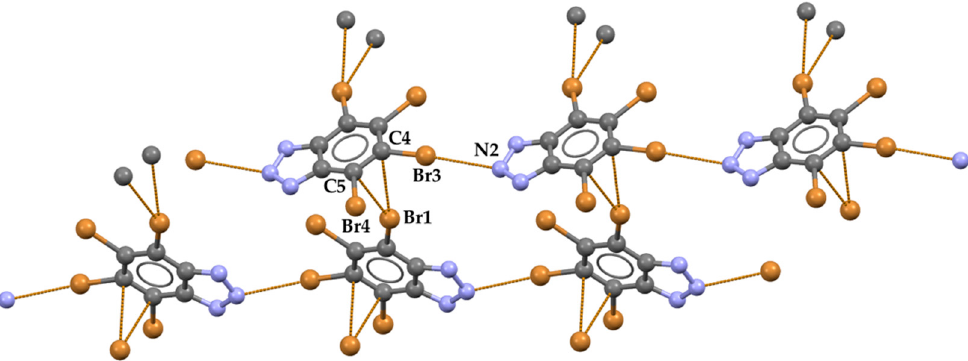
Figure 3. Partial view (Mercury 3.9) of two infinite chains formed by Br ∙∙∙ N halogen bonds and bridged by Br ∙∙∙π halogen bonds. Both halogen bond types are brown dotted lines. The color code of atoms is the same as that in Figure 1.